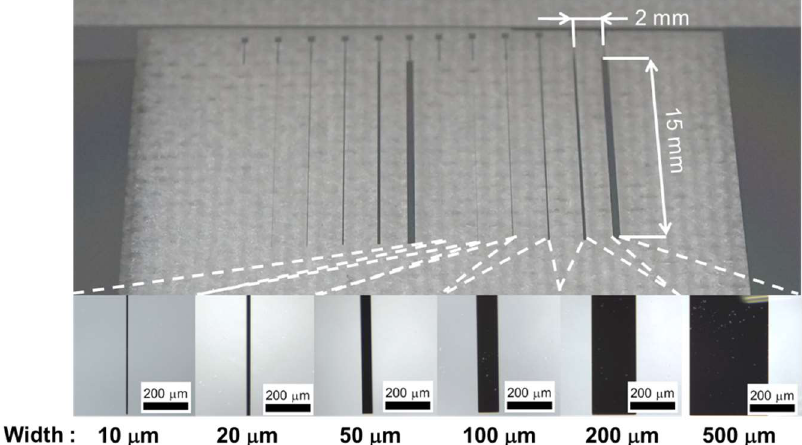
Figure 4. Images of the fabricated array of the electrodes. Two sets of the electrodes with widths of 10, 20, 50, 100, 200, and 500 μm were formed on a glass substrate. The designed pitch of the electrodes was 2 mm. The length of the electrodes was 15 mm.